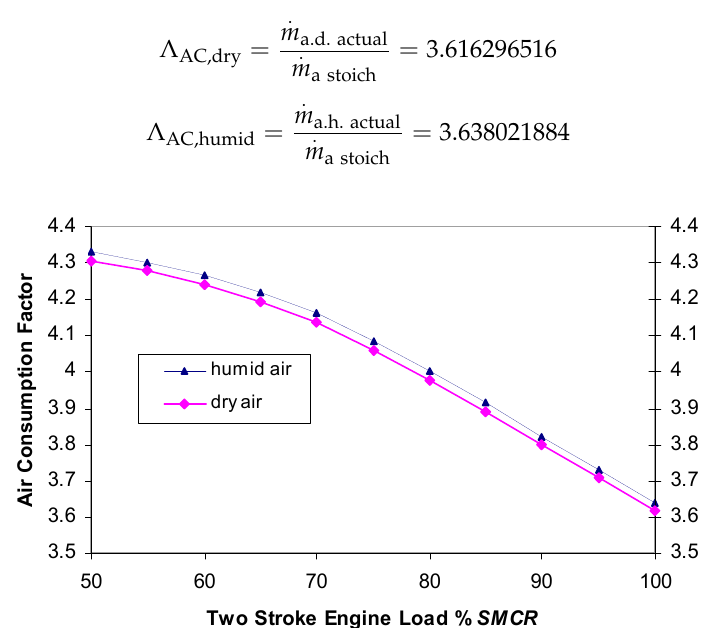
Figure 7. Air consumption ratio in the function of main engine load.